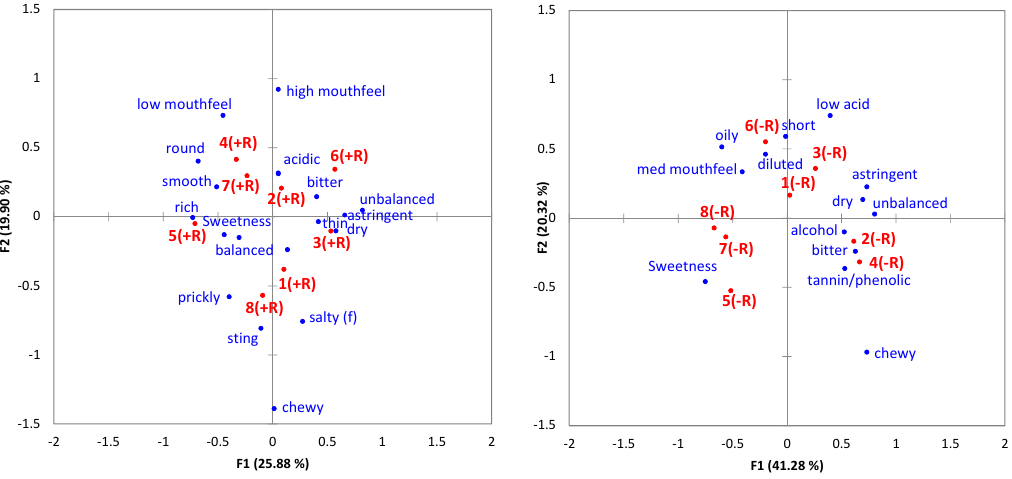
Figure 2. Correspondence analysis of terms used for Ultra Flash Profiling (UFP) analysis (A = +R, B = − R).